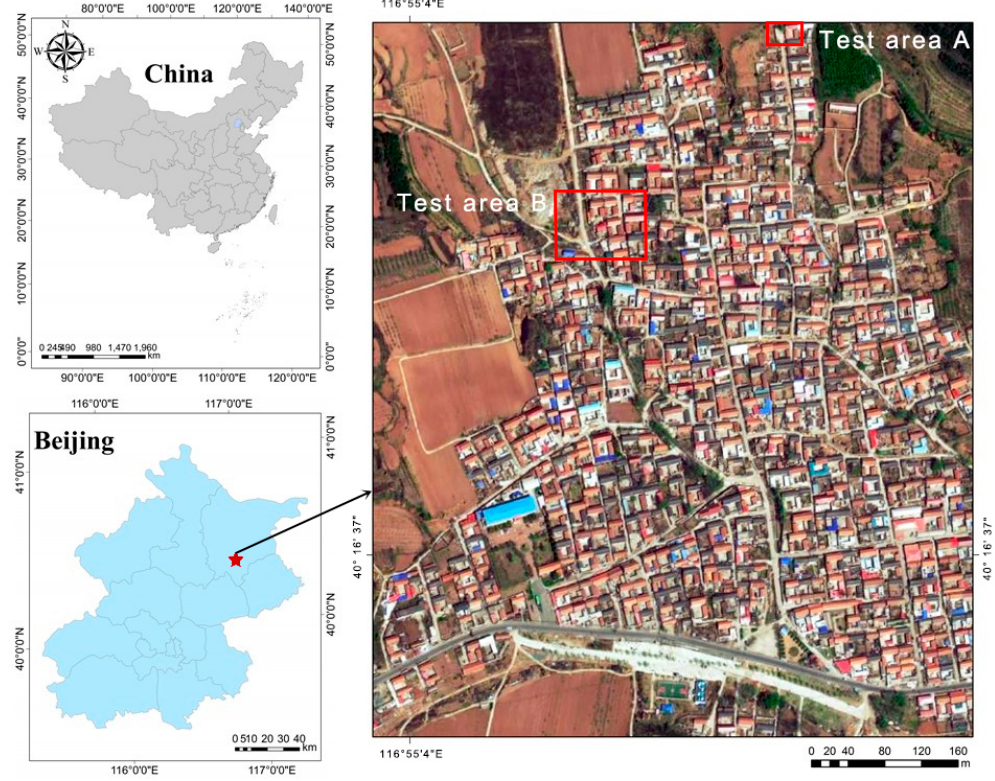
Figure 2. Overview of the study area.